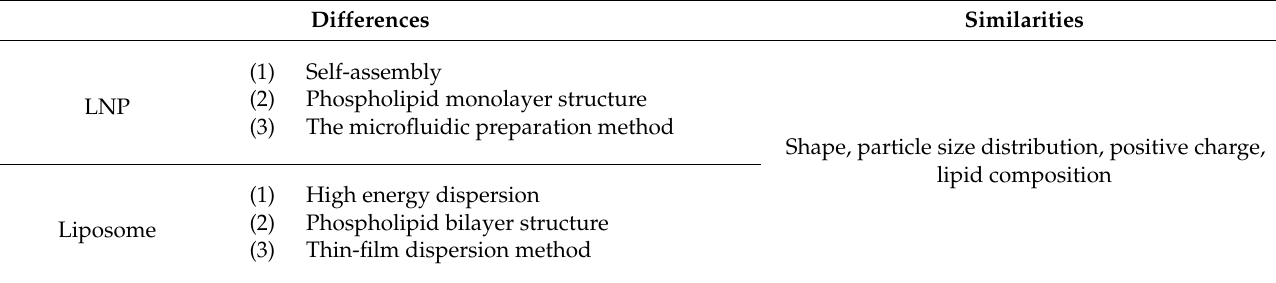
Table 1. The comparison between LNPs and